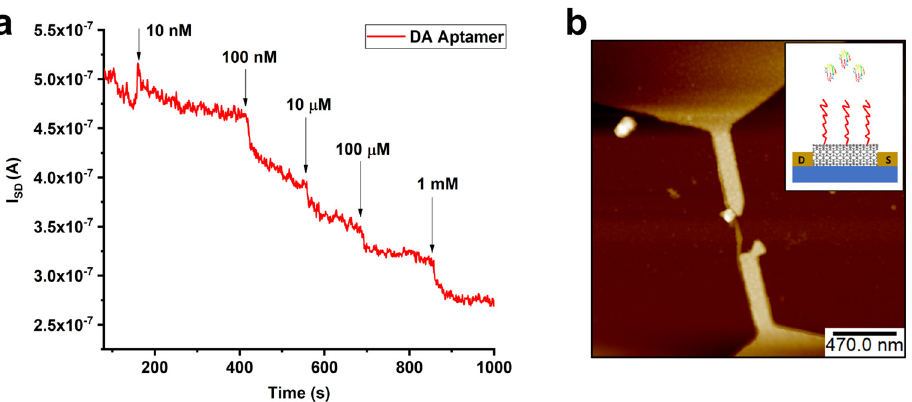
Figure 10. ( a ) Real-time detection of dopamine at various concentrations (10 nM to 1 mM). ( b ) AFM image of the dopamine binding aptamer functionalized CNTFET. Inset: Cartoon of the aptamer- CNTFET.